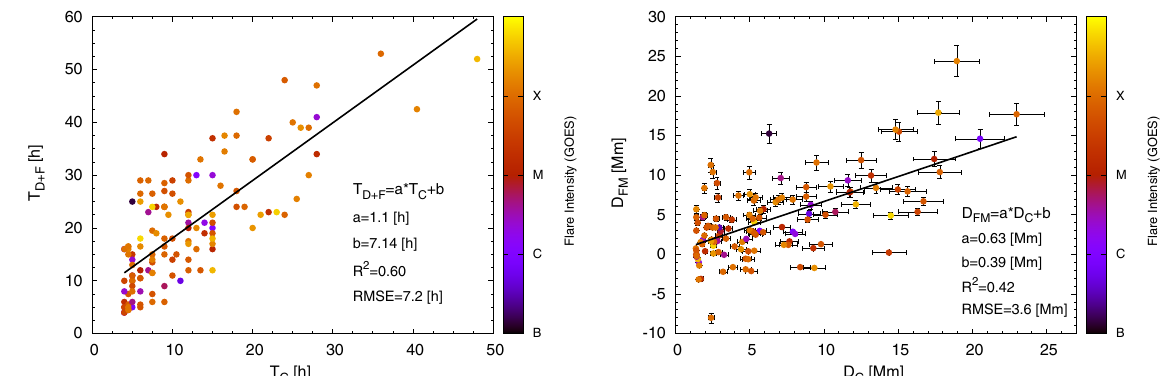
Fig. 5. Left : Relationship between the durations of converging motion and the duration from the moment of time of closest position up to the fi rst fl are occurrences. Right : Relationship between difference of the distances between the barycenters at the start of the convergence phases and at the closest approach ( D C ) and the distance between the point of closest approach to the position of fi rst fl are occurrence ( D FM ) at photospheric level. The estimated errors are given in the lower